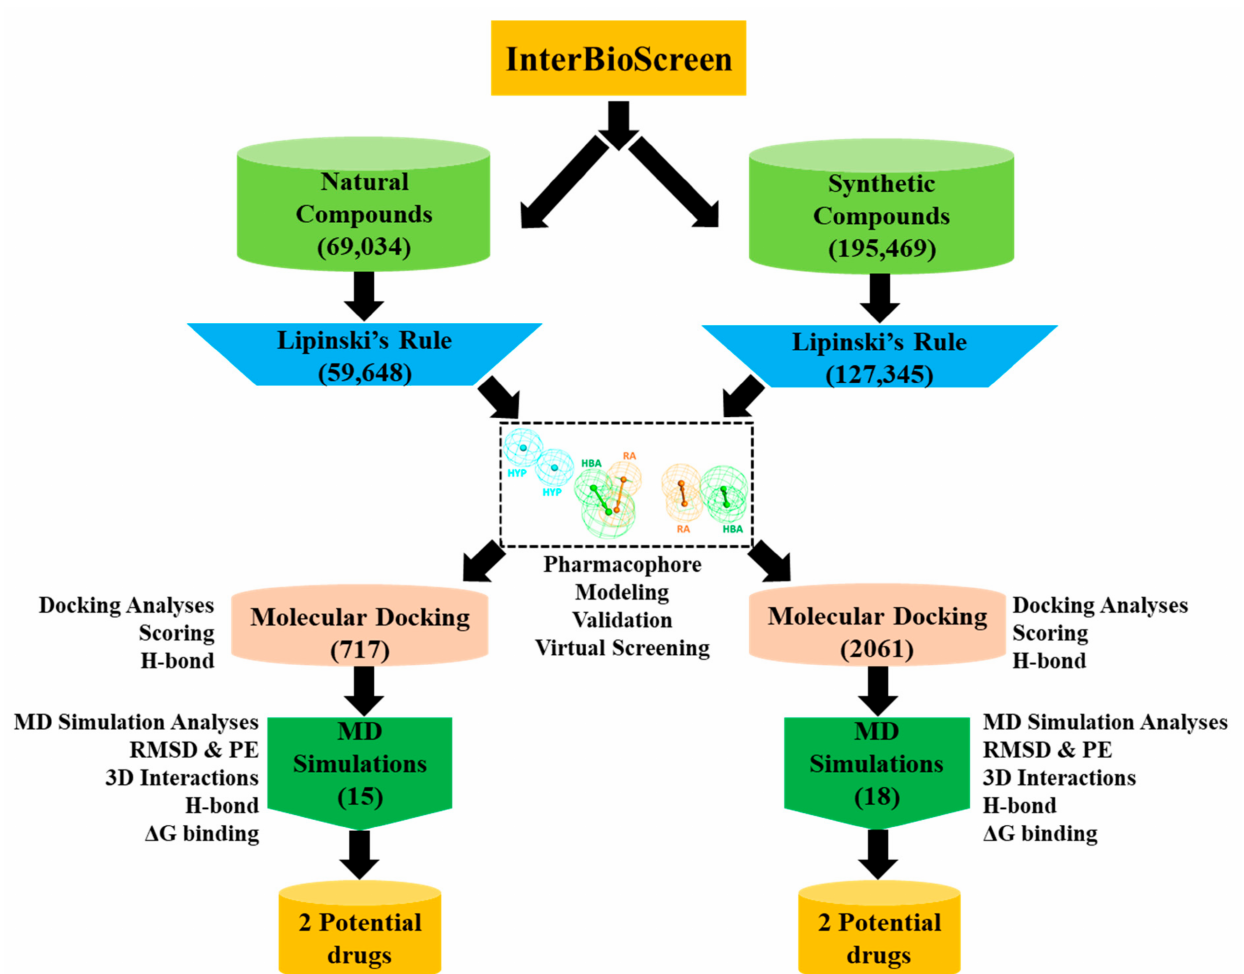
Figure 1. Flowchart depicting the working methodology in the current study used for the identification of potential Heparanase